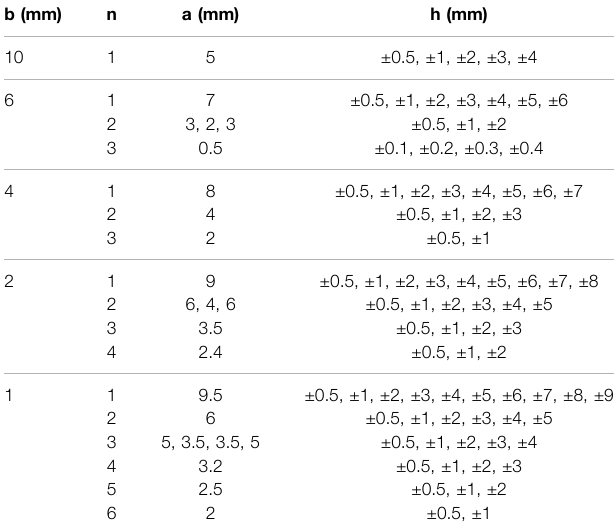
TABLE 2 | Different working